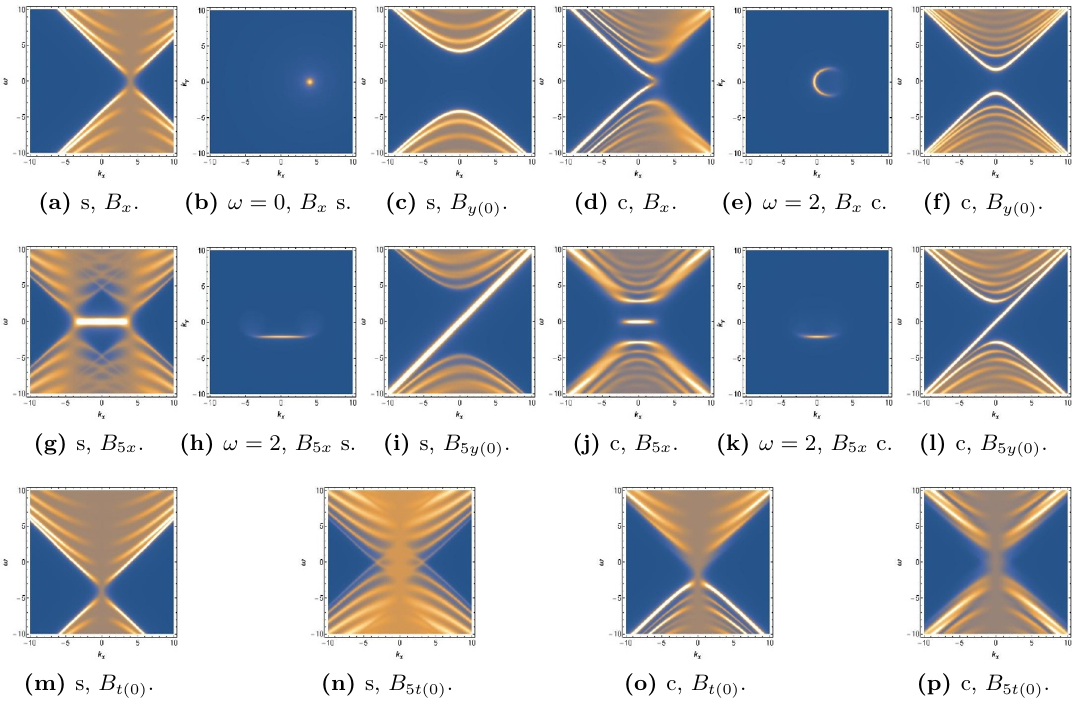
Figure 14. SF with most typical vector interactions. For SF with B t and B 5 t , these are the same as those of 2-flavors due to the rotational symmetry in xy